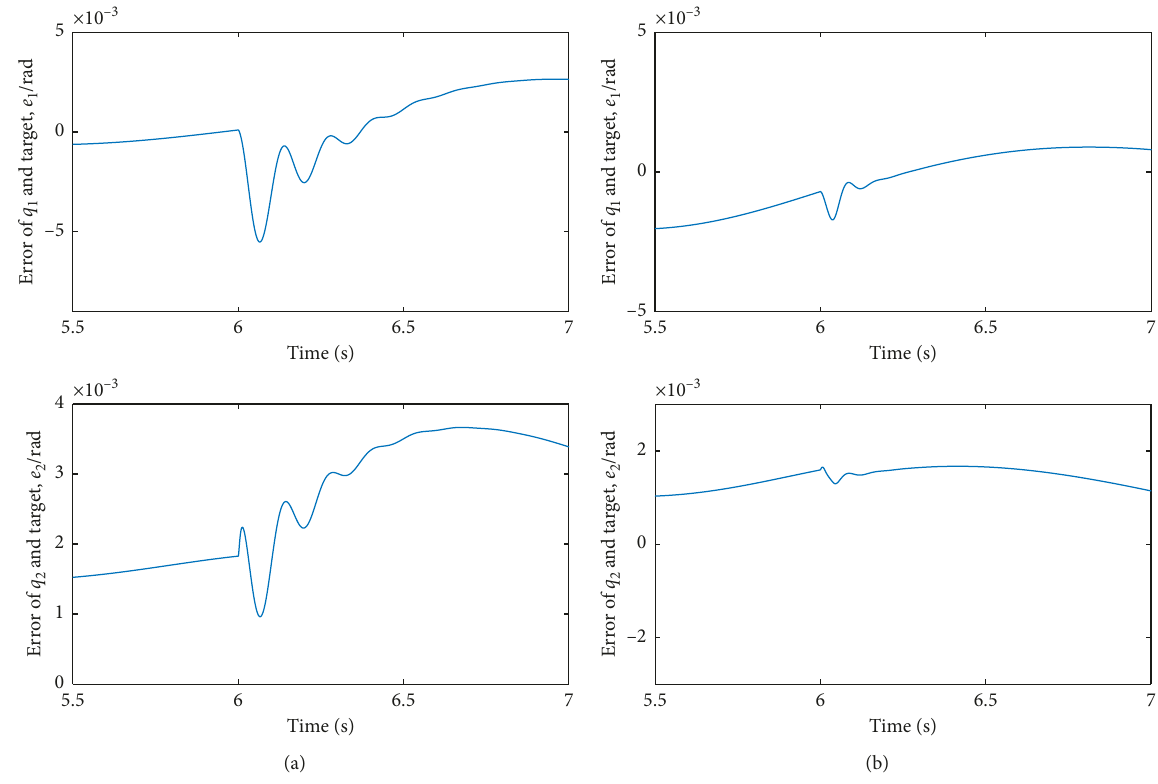
Figure 14: Transient performance of (a) single NN-based controller and (b)